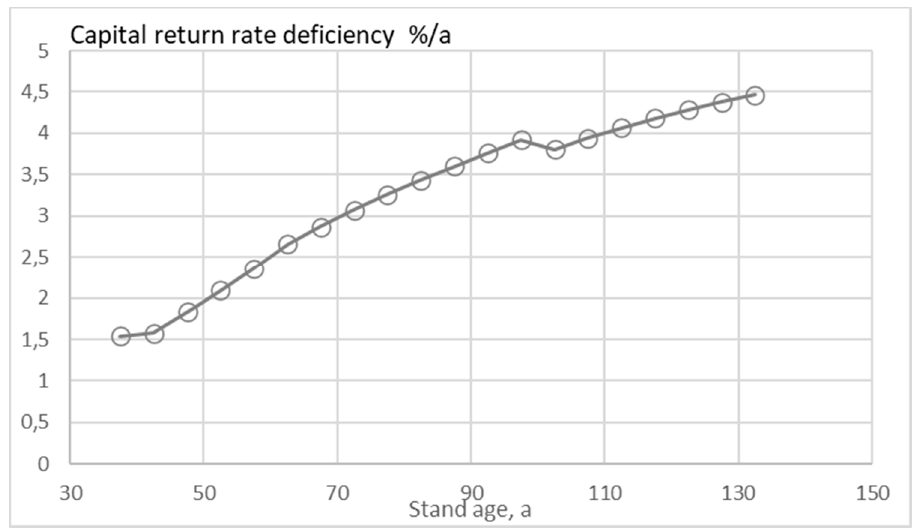
Figure 13. Capital return rate deficiency in percentage per year, with thinnings from below.